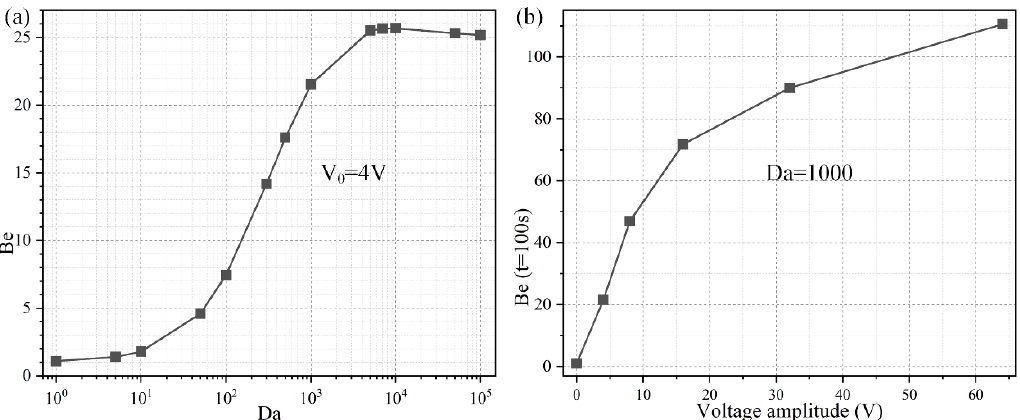
Figure 6. Effect of Da number on the binding efficiency improvement due to the action of ROT-ICEO slipping flow. ( a ) A data point plot of the binding enhancement factor Be with respect to an increasing Da number under AC voltage V 0 =4V and field frequency f = 200 Hz. ( b ) Voltage-dependent Be for different voltage amplitudes at t = 100 s when Da = 1000.